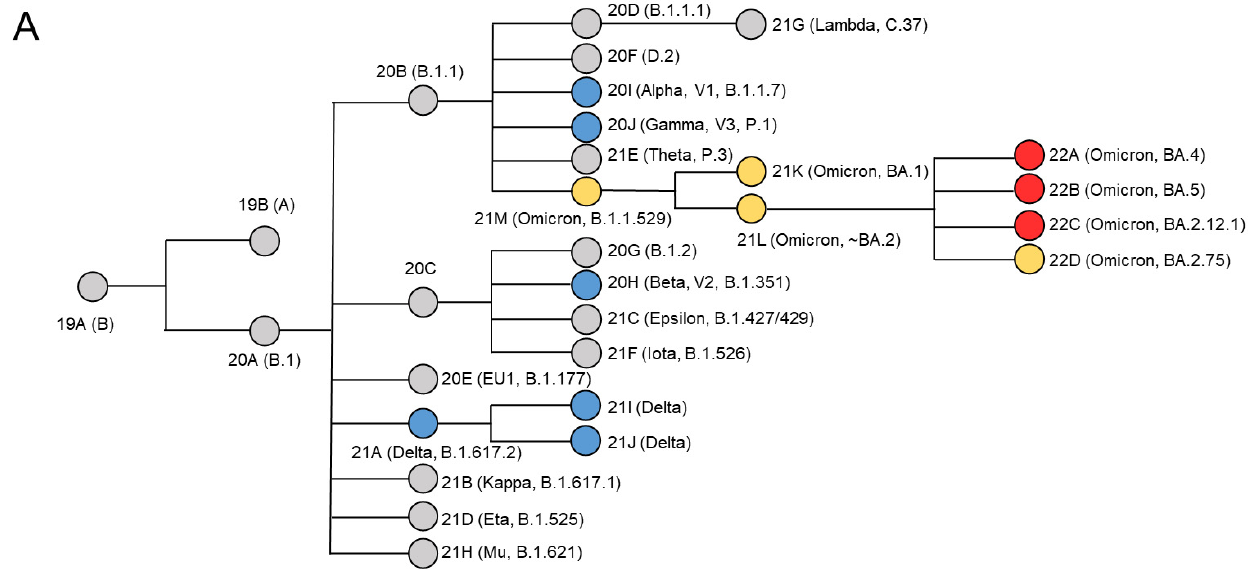
Figure 1. Phylogenetic tree and multiple sequence alignment. ( A ) Phylogenetic relationships of Nextstrain SARS-CoV-2 clades. The phylogenetic tree was adapted from figure provided by Nextstrain and CoVariants [29]. VOCs are represented by colored nodes. ( B ) Mutation profile of S protein RBD of Omicron BA.2.12.1, BA.4/BA.5 compared with WT. Multiple sequence alignment was performed by Clustal Omega (1.2.4). An * (asterisk) indicates positions which have a single, fully conserved residue. 3.2. Binding Affinity and Kinetics Measurement on S Protein RBD–Heparin Interactions Heparin/HS has variable repeating units, L-iduronic acid (IdoA) or D-glucuronic acid (GlcA) linked to N -sulfoglucosamine (GlcNS) or N -acetylglucosamine (GlcNAc), with dif- ferent sulfo group modification [30]. Heparin/HS and other GAGs interact with proteins mainly through their highly negatively charged groups (sulfo groups and carboxyl groups) in polysaccharide chains binding to basic amino acid residues of proteins, for which a limited number of specific binding cases have, thus far, been discovered [31]. HS interacts with SARS-CoV-2 S protein and facilitates host cell entry of SARS-CoV-2 as a co- receptor of ACE2 [17]. Destabilizing and stabilizing mutations may have a large impact